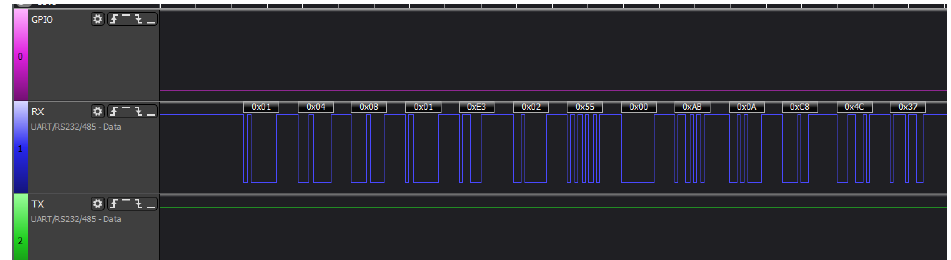
Figure A1. Tests of command sending from Sensor to